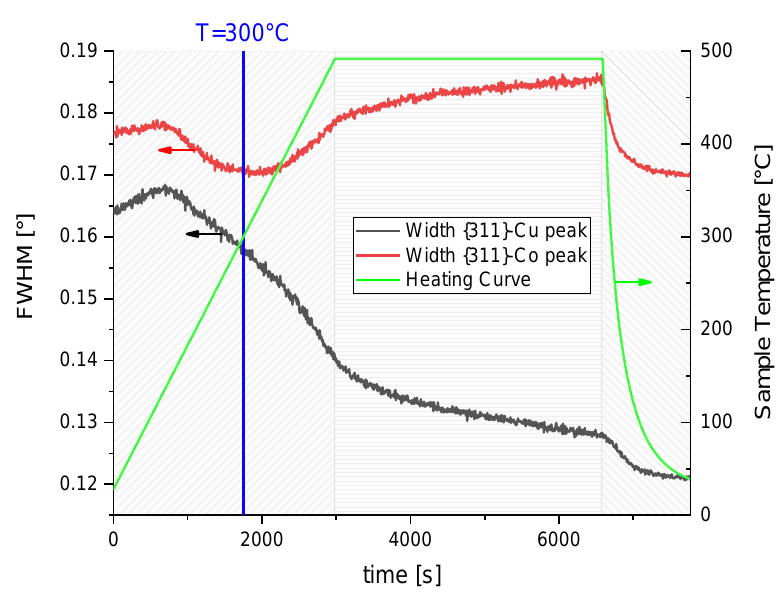
Figure 4. Full width at half maximum (FWHM) of pseudo-Voigt function in course of the complete in-situ HEXRD experiment. The heating curve is shown and the time when the specimen reaches a temperature of 300 °C is emphasized.